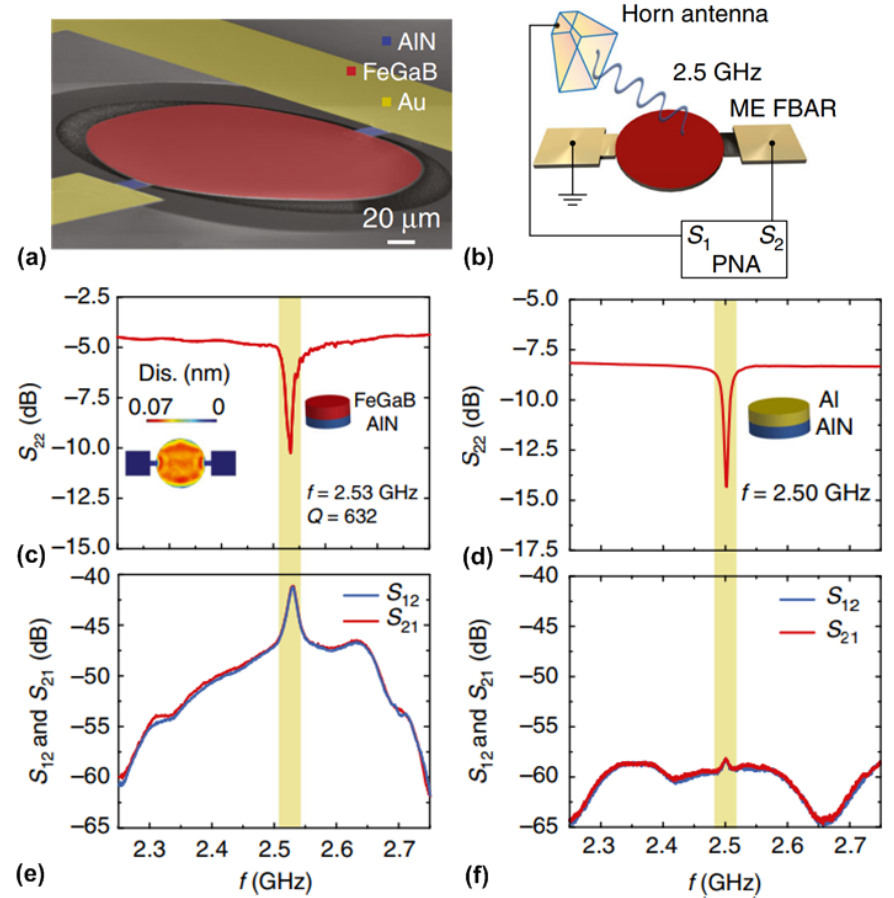
Figure 10. ( a ) SEM of the FABR-type mechanical antenna; ( b ) schematic of the gain measurement setup using Horn antenna and network analyzer; ( c ) measured reflection coefficient (S 22 ) of the FABR-type mechanical antenna. The inset shows the out-of-plane displacement of the circular disk at resonant frequency; ( d ) measured reflection coefficient (S 22 ) of the nonmagnetic Al/AlN control device; ( e ) Measured transmission coefficients (S 21 and S 12 ) of the FABR-type mechanical antenna; and ( f ) measured transmission coefficients (S 21 and S 12 ) of the nonmagnetic Al/AlN control device. This figure is reproduced from [121].